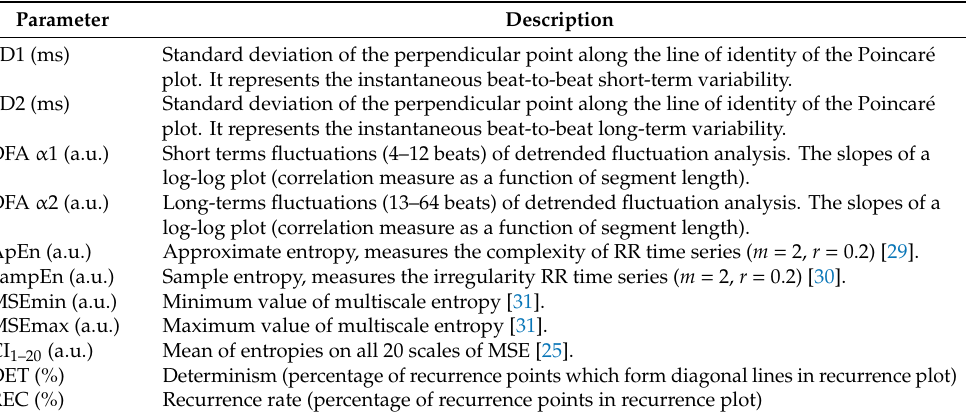
Table A3. Description of non-linear HRV